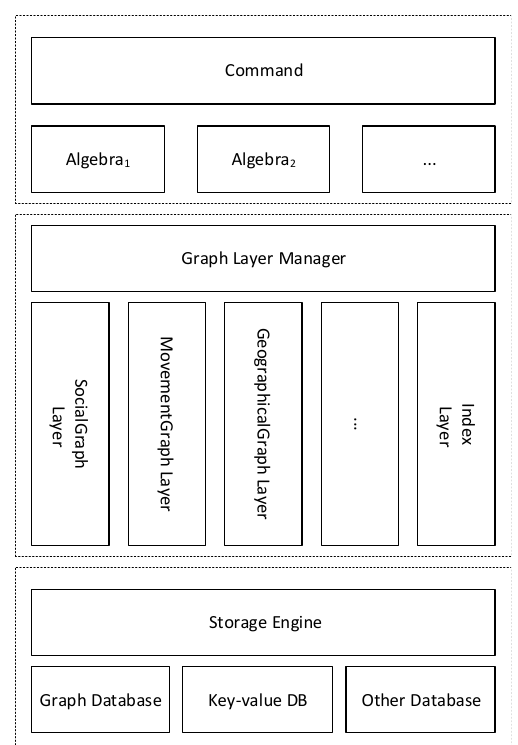
Figure 5. Implementation framework for the GSM